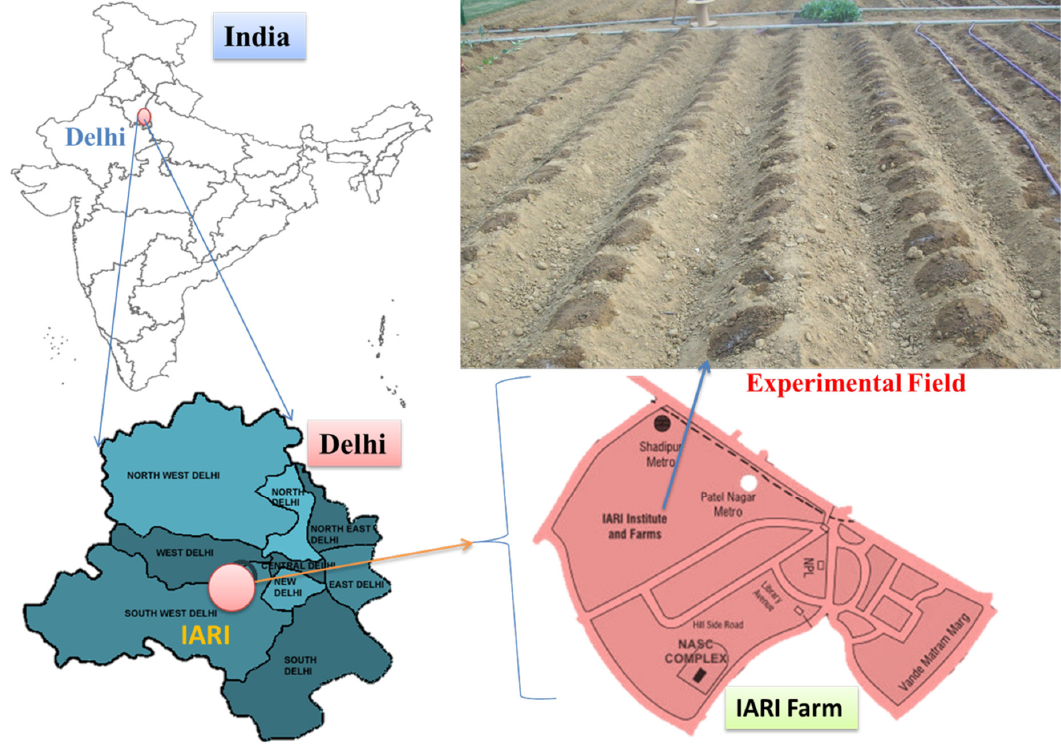
Figure 1. Location map of the experimental site in semi-arid peri urban area, Delhi, India.